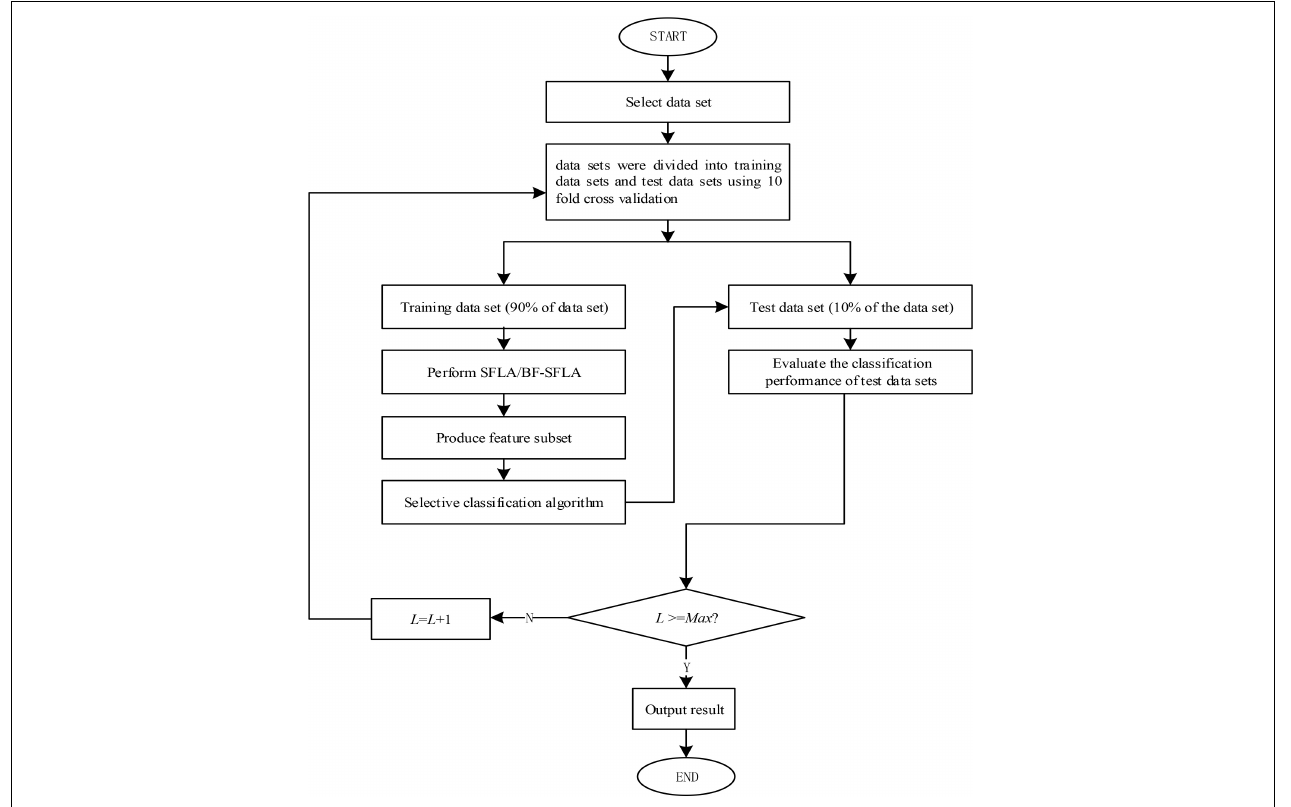
FIGURE 4 | The feature selection flow